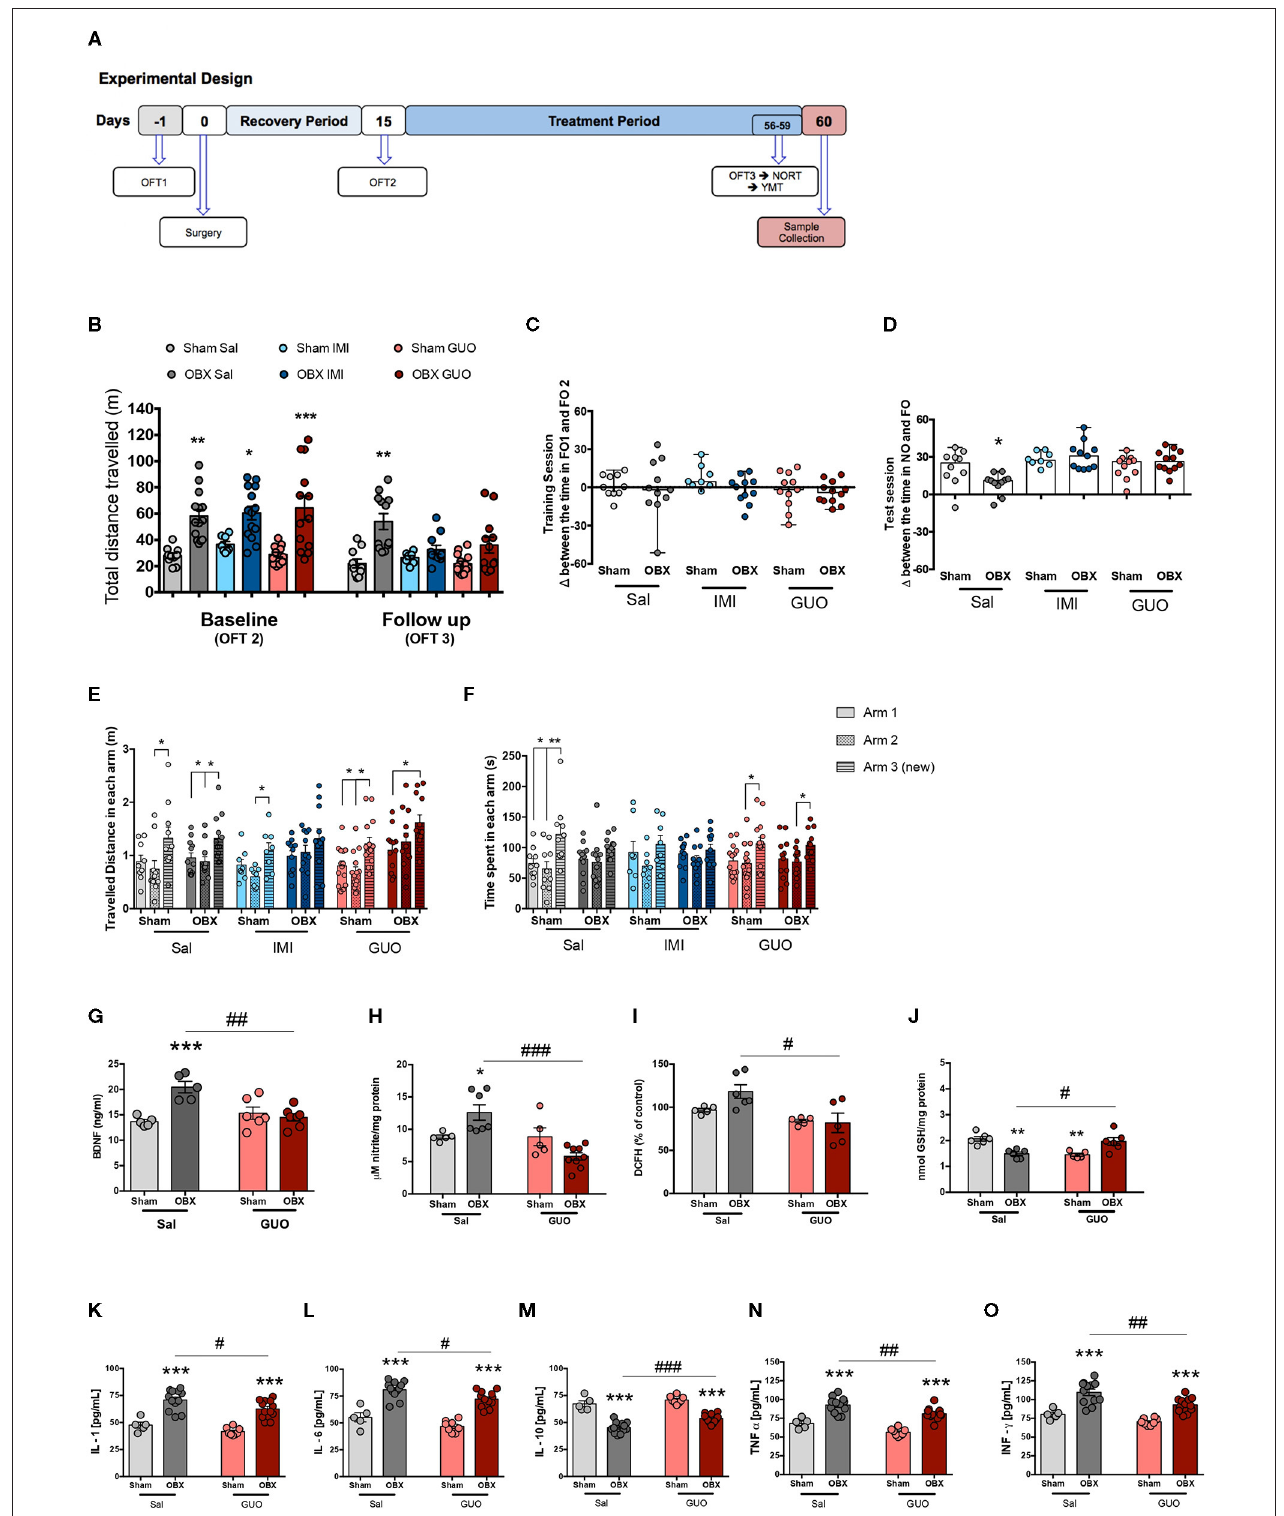
FIGURE 1 | Cohort 1: study design (A) . Surgery and treatment effects in locomotor activity in OFT (B) : Columns represents mean ± S.E.M. (n = 8–14 mice/group). * p < 0.05, ** p < 0.01, *** p < 0.001 OBX x respective Sham, two-way ANOVA/Tukey. (C,D) : Delta ( 1 ) between the time spent exploring objects in NORT training (FO1 and FO2) (C) and test (D) (NO and FO) sessions, respectively. Columns represent median with range ( n = 8–12). * p < 0.05, ** p < 0.01, *** p < 0.001, two-way